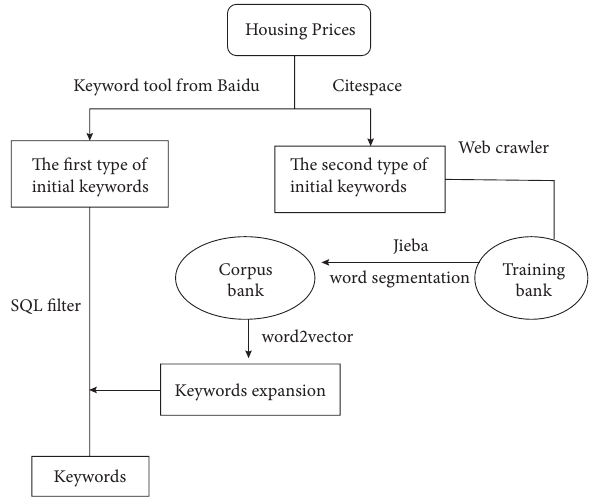
Figure 3. The structure of text mining to search for